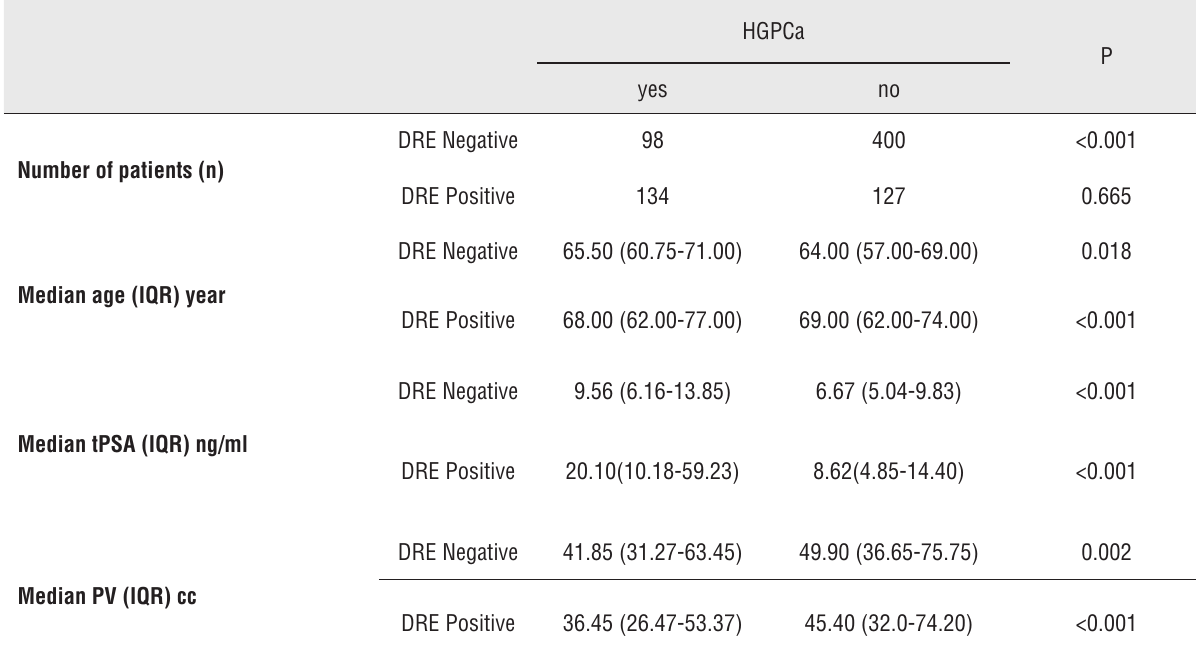
Table 1 - Patient characteristics according to presence or absence of